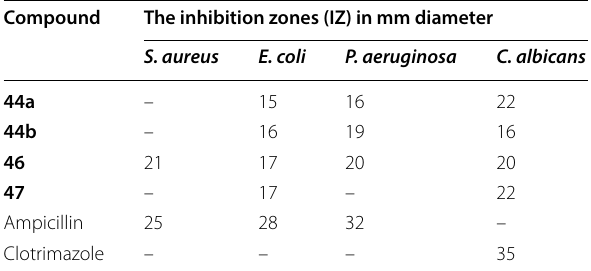
(–) no inhibition zone, Minimum Inhibitory Concentrations was expressed as (µg/ml)